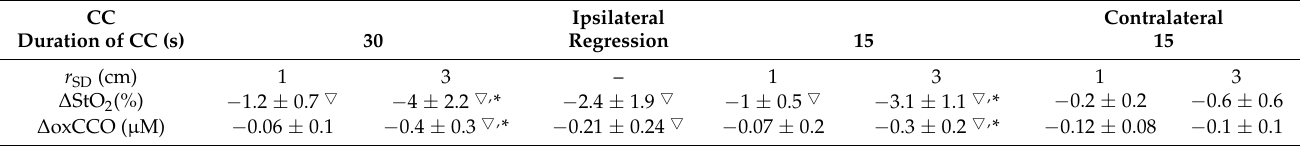
Figure 3. Average changes in StO 2 , oxCCO, and BFi in response to ipsilateral ( a ) 30-s CC (blue region between 1 and 1.5 min) and ( b ) 15-s CC (blue region between 0.5 and 0.75 min). Time courses were averaged across subjects, and shading surrounding each line represents the standard deviation. Table 1. Average oxygenation and metabolic responses for 30-s and 15-s